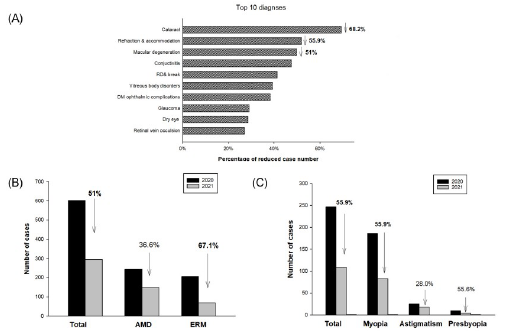
Fig 4. (A) Ten most prominent diagnoses that decreased in number during the COVID-19 pandemic period. (B) Subgroup analysis in macular degeneration. (C) Subgroup analysis in refraction & accommodation. RD, retinal detachment; DM, diabetes mellitus; AMD, age-related macular degeneration; ERM, epiretinal